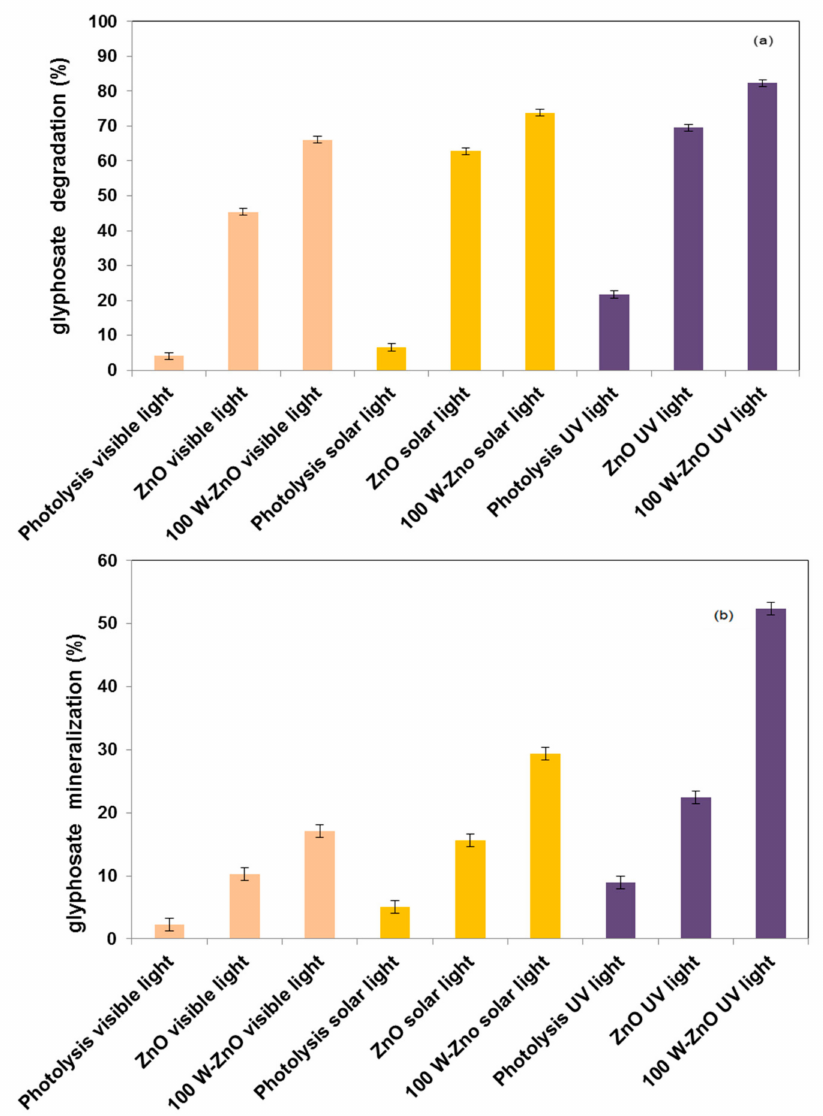
Figure 7. Photocatalytic glyphosate degradation ( a ) and mineralization ( b ) of ZnO and 100 W-ZnO under different light sources under the irradiation time; initial glyphosate concentration: 20 mg/L; pH = 7; catalyst dosage = 1.5